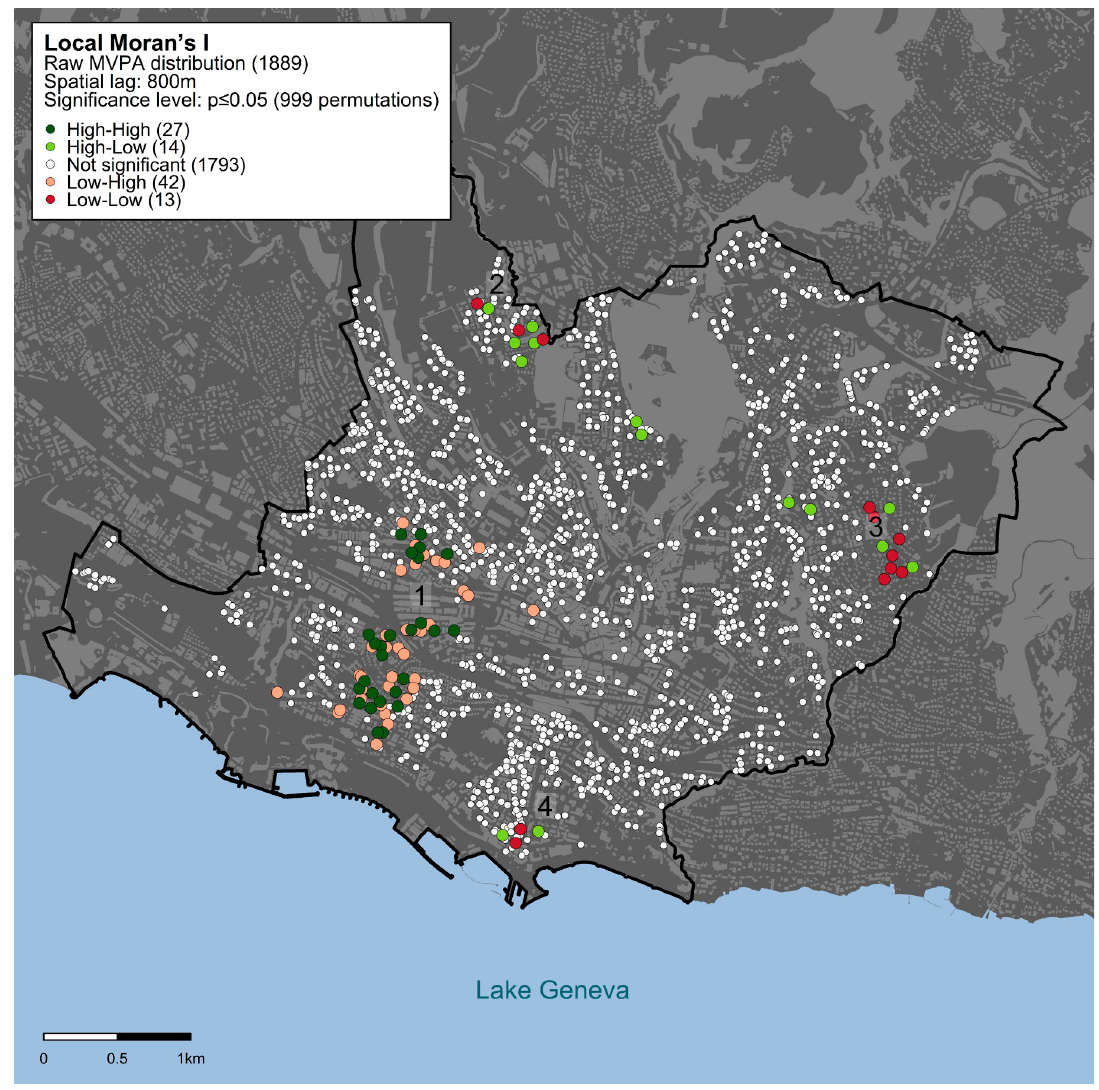
Fig 1. Spatial clusters of raw MVPA using Local Moran’s I statistics. Statistical significance is assessed based on an α threshold of p < 0.05 within a spatial lag of 800 m. Dark-green dots indicate individuals with high MVPA values surrounded by neighbors also showing high MVPA values; red dots indicate individuals with low MVPA surrounded by neighbors with low MVPA values; light-green dots indicate individuals with high MVPA values surrounded by neighbors showing low MVPA values; pink dots indicate individuals with low MVPA values surrounded by neighbors with high MVPA values; white dots indicate individuals whose MVPA values are randomly distributed in the geographic space. Landmarks (1–4) are shown to facilitate the description and interpretation of the results. Map was created using data from the Swiss Federal Office of Topography